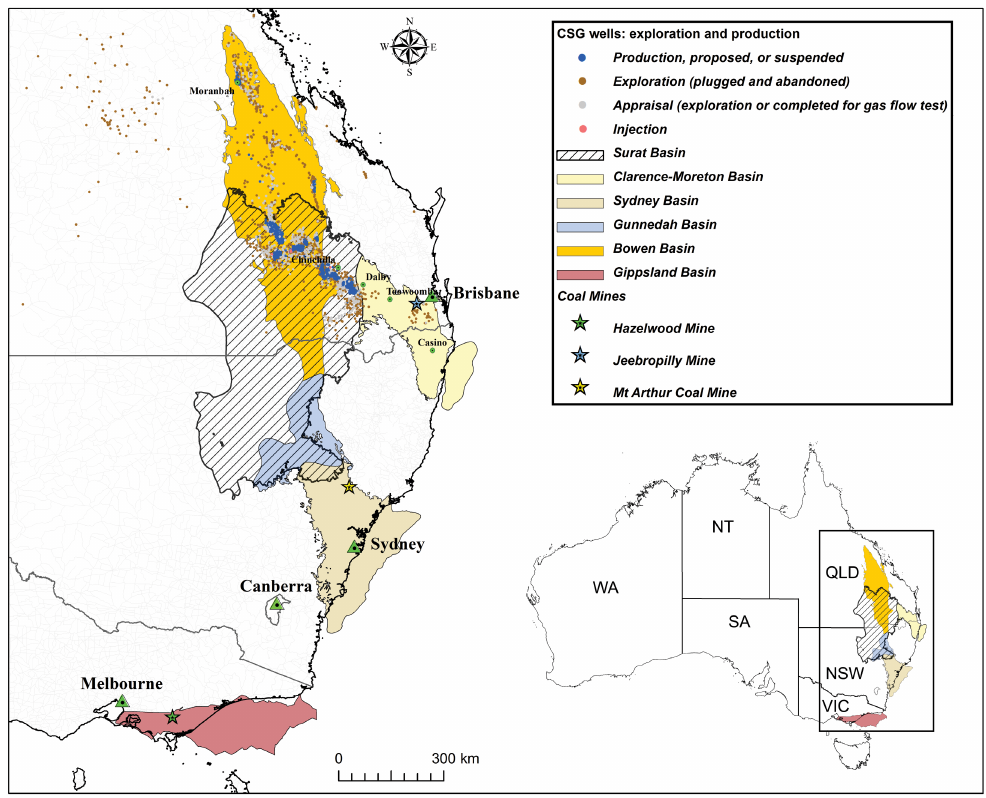
Figure 1. Coal seam gas (CSG) water study areas and localities for coal samples used in leaching experiments. The red boxes mark high production areas where CSG water is extracted from the Bandanna Formation (Bowen Basin) and Walloon Coal Measures (Surat Basin). The desktop CSG water quality data was taken from these